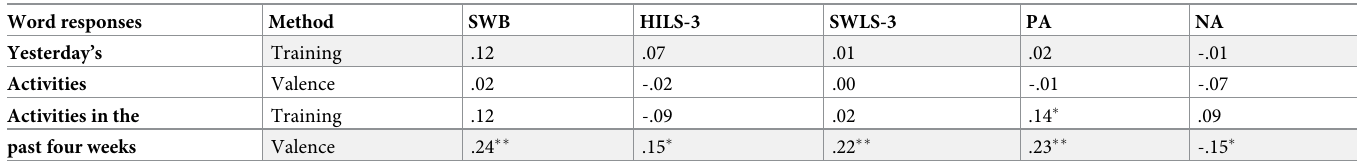
Table 2. Pearson correlations between language-based predictions of SWB and observed SWB scale